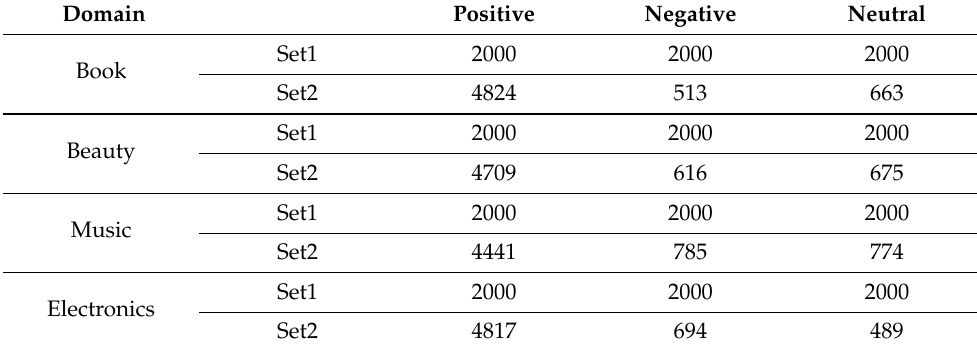
Table 2. Statistics of Dataset